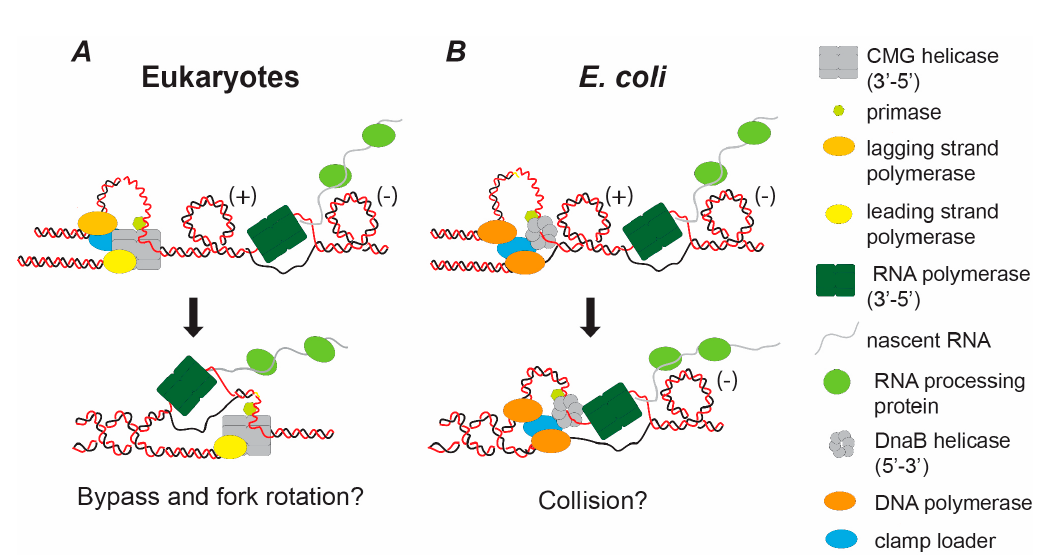
Figure 3. Hypothetical models of the consequences of topological stress and head ‐ on replication ‐ transcription conflicts in eukaryotes and E. coli . Head ‐ on collisions between the DNA replication machinery and active transcription will lead to high levels of positive (+) super ‐ helical stress ahead of the fork. There will also be negative ( − ) superhelical stress behind the transcription bubble. Analogous to the termination of DNA replication, the converging replication and transcription machineries will progressively sterically occlude topoisomerases from acting on the positive (+) super ‐ helical stress between the complexes, inhibiting unwinding. This is likely to initiate replication fork rotation. As the replication and transcription machineries fully converge there are likely to be distinct consequences in eukaryotes ( A ) compared to E. coli ( B ). ( A ) In eukaryotes both the CMG helicase and the RNA polymerase translocates 3’ ‐ 5’. These will converge on different strands. If the complexes act the same way as converging complexes in termination they will bypass one another. ( B ) In contrast, in E. coli the replication helicase DnaB translocates 5’ ‐ 3’, travelling on the same strand as the converging RNA polymerase travelling 3’ ‐ 5’. Therefore, these complexes will collide unless the RNA polymerase is displaced.